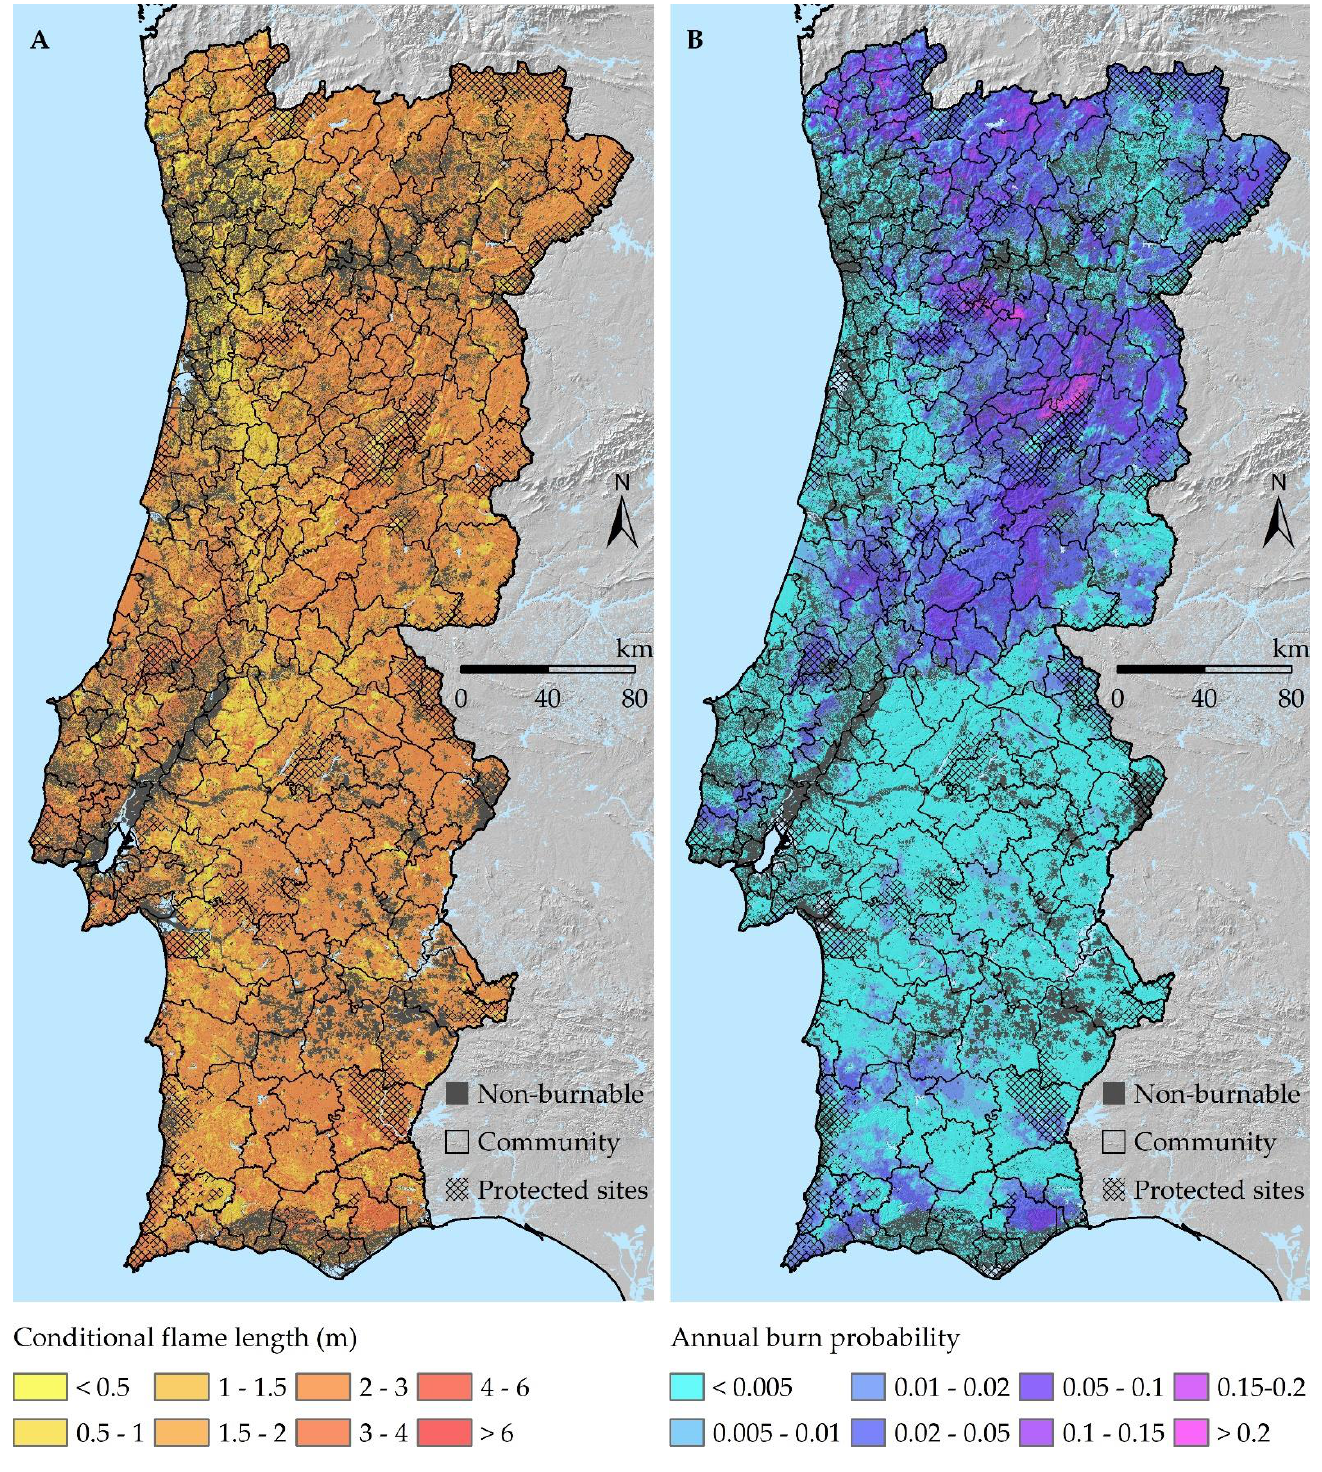
Figure 2. Modeled wildfire intensity ( A ) and likelihood ( B ) in Portugal. We modeled a burned area equivalent to 10,000 years at 100 m resolution with the MTT algorithm as implemented in the FConstMTT command line fire spread and behavior modeling program. The fire ignitions were distributed based on large fire ignition density (Figure 1A). We assumed extreme weather conditions to model fire spread and behavior (Table 1).